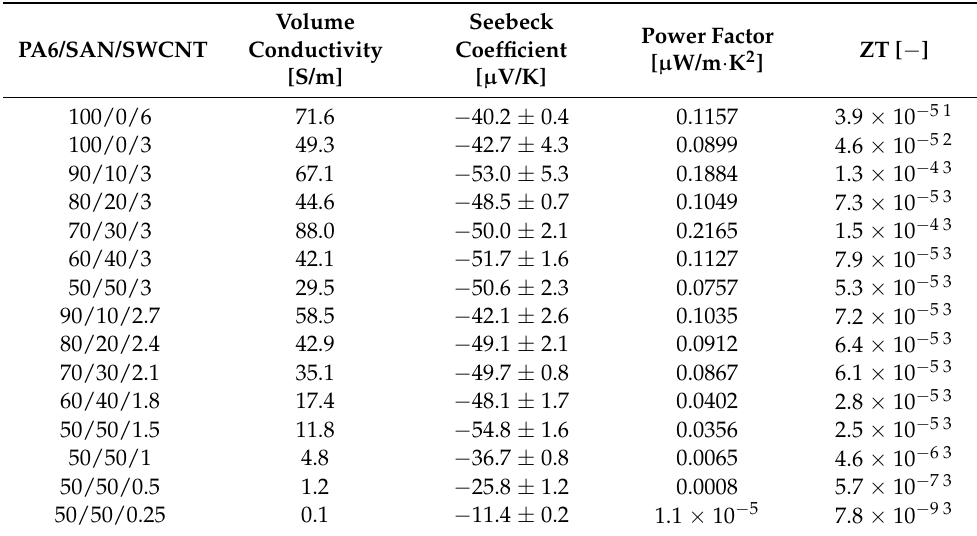
Table A2. TE parameters of PA6/SAN/SWCNT blends.